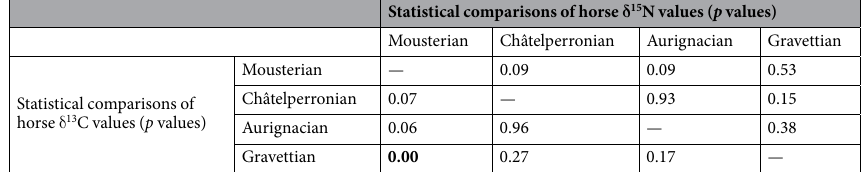
Table 7. Statistical test results comparing horse δ 15 N and δ 13 C values within each cultural period. Statistically significant p values are highlighted in bold.